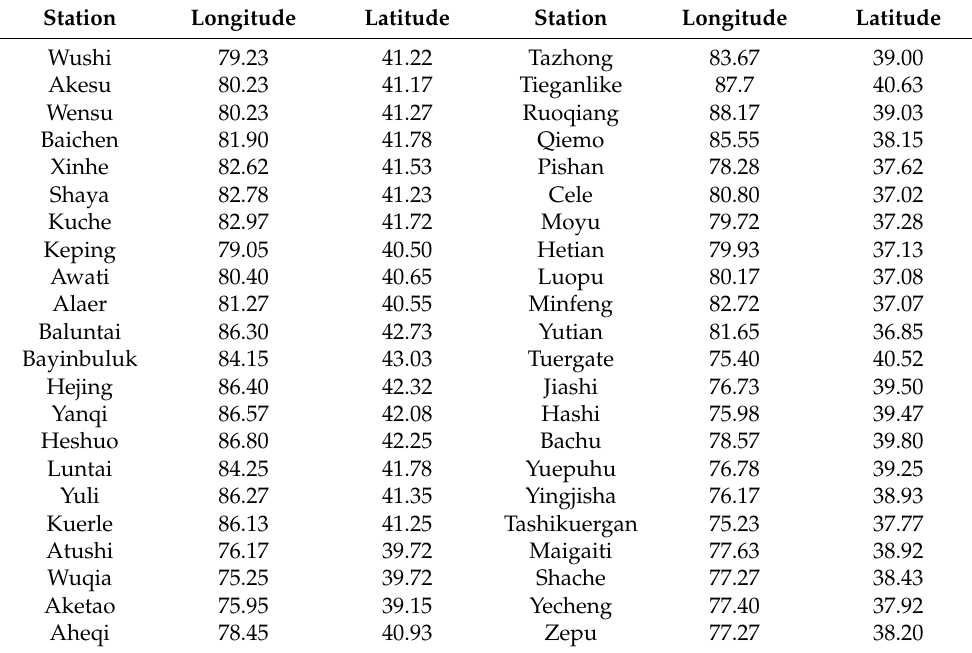
Table A1. Surface meteorological station